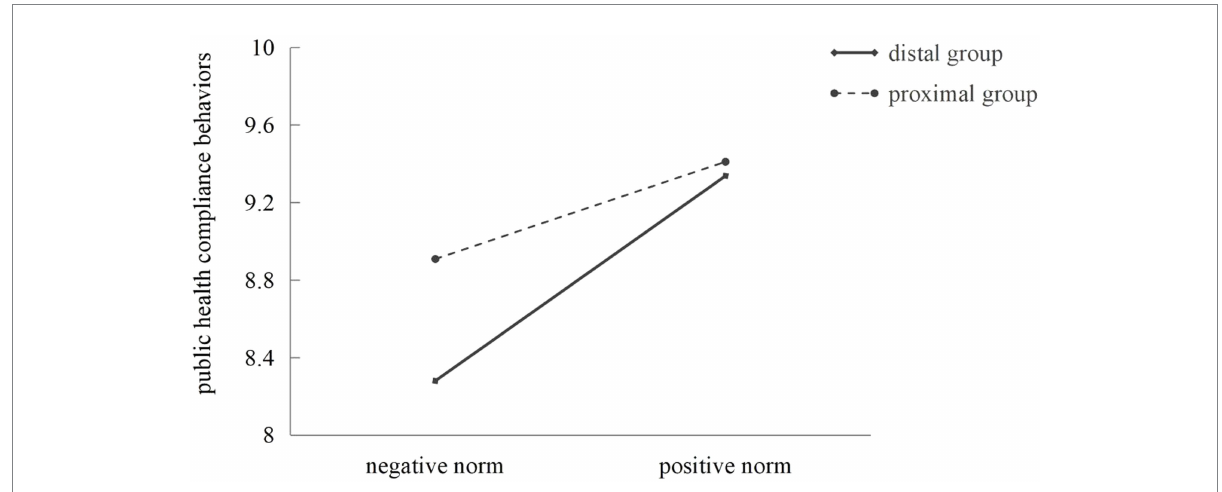
FIGURE 3 The interaction effect of the property and the reference group of descriptive norms on public health compliance